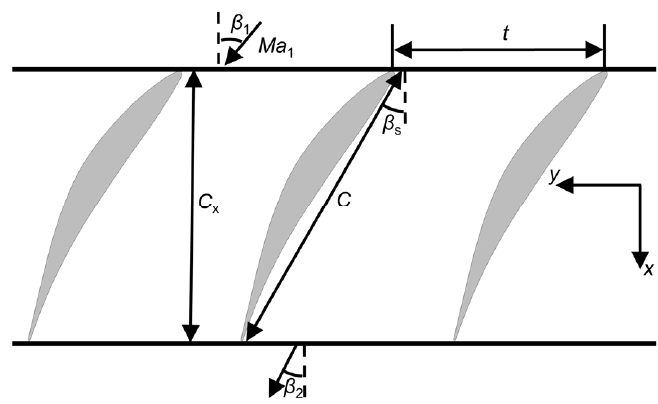
Figure 5. Evaluation of axial velocity difference.